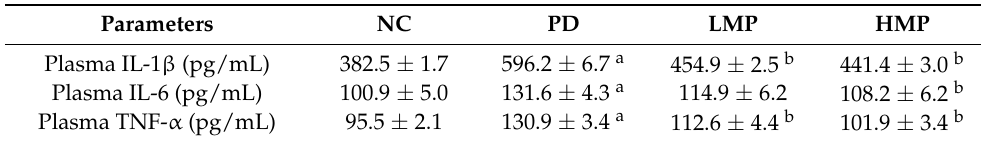
Table 3. Plasma levels of inflammatory cytokines after 8 weeks of supplementation in the rat model of PD.